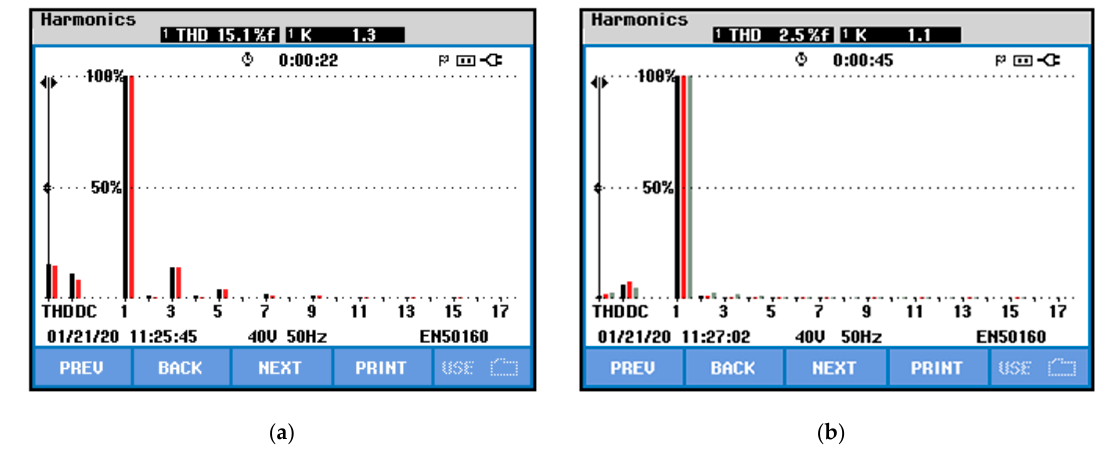
Figure 26. Frequency spectrum of the three-phase currents at the secondary windings of the V/V transformer (when one load section is loaded): ( a ) before compensation; ( b ) after compensation.